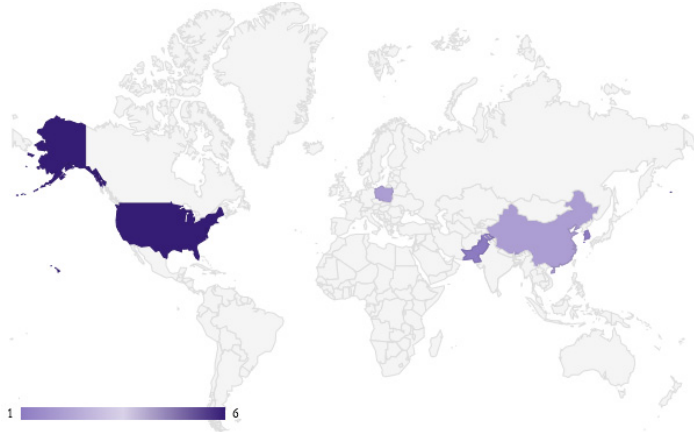
Figure 2. Graphical map of the geographical distribution of selected studies.